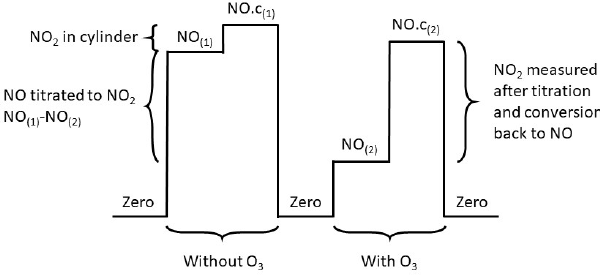
Figure 3. A theoretical calibration cycle. “NO” is the measurement of only NO, i.e. when the converters are off; “NO.c” is when one of the converters are on therefore the measurement is NO + NO 2 ; and (1) and (2) represent untitrated and titrated NO,